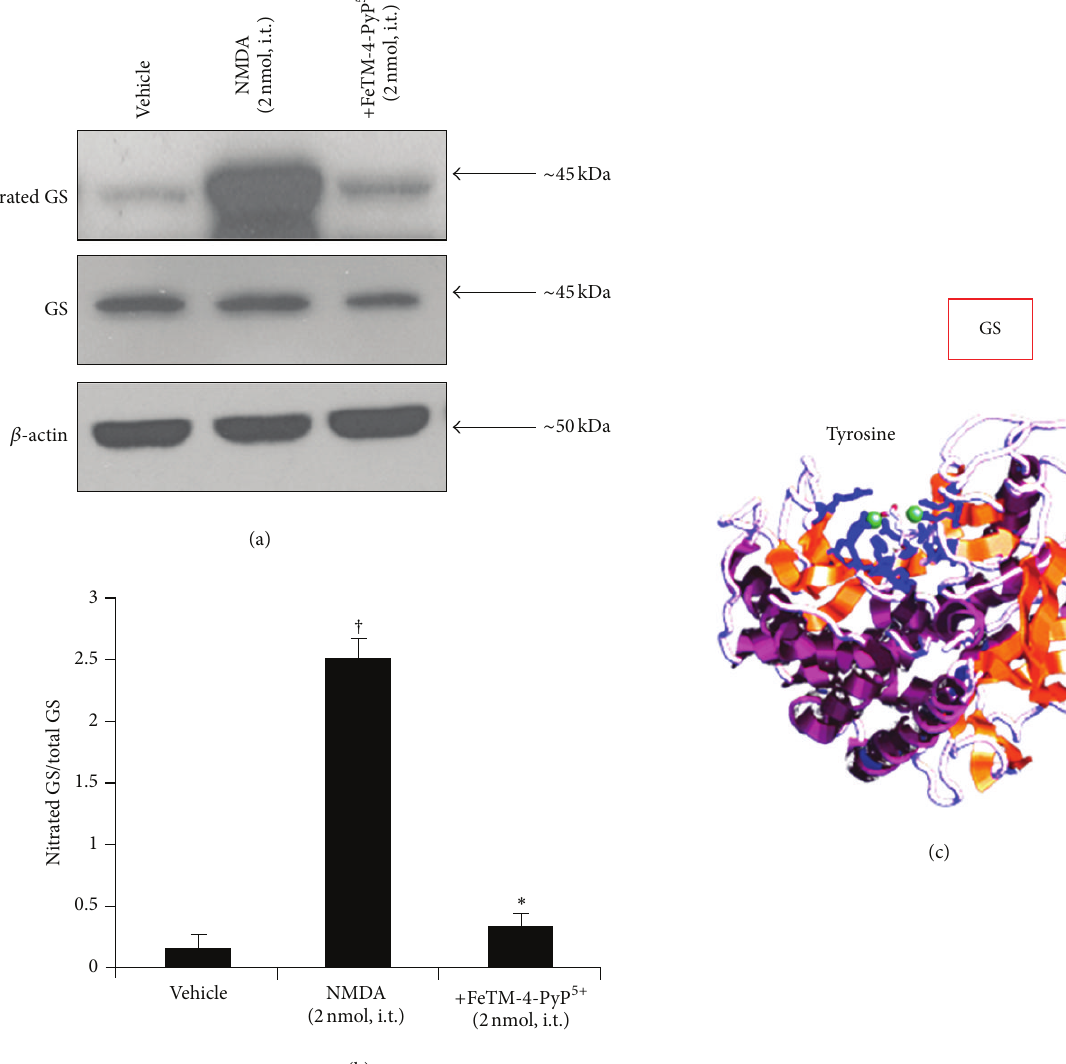
Figure 5: Nitration of glutamine synthase occurs following NMDA (2nmol) induced thermal hyperalgesia ((a)–(c)). The time at which the NMDA mediated hyperalgesia was at its peak (40 minutes), immunoprecipitation analysis revealed that FeTM-4-PyP 5+ (2nmol given 15min before NMDA) reduced the NMDA mediated nitration of GS at the level of the spinal cord ((a)–(b)). Immunoprecipitation data are representative of at least 6 gels from 3 different animals performed on different days. Bar graph in (b) represents quantification by densitometric analysis. No difference for GS or 𝛽 -actin expression was detected among the lanes in these conditions. † 𝑃 < 0.001 compared to vehicle and ∗ 𝑃 < 0.001 compared to NMDA